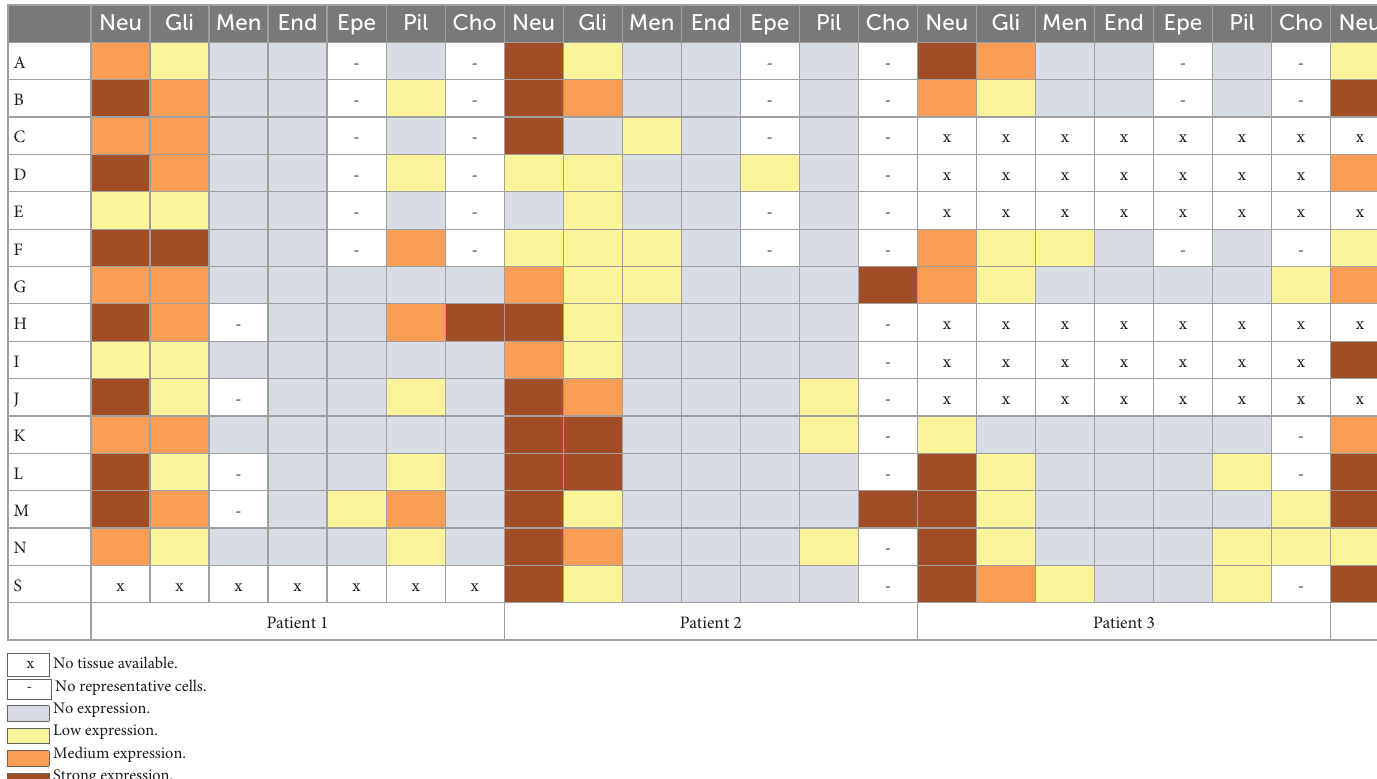
TABLE 3 Expression of the NHLRC2 in different brain regions and cell types in the deceased FINCA patients and in the control samples.